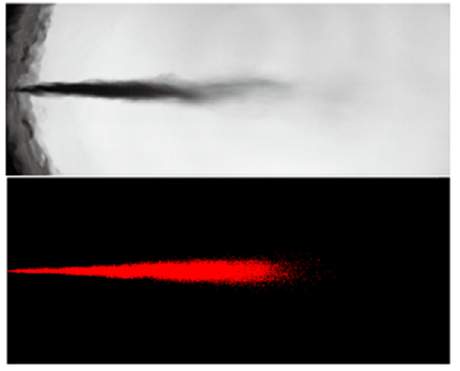
Figure 5: Comparison of experimental and numerical results of the spray ( at 2.0 ms ASOI ) .